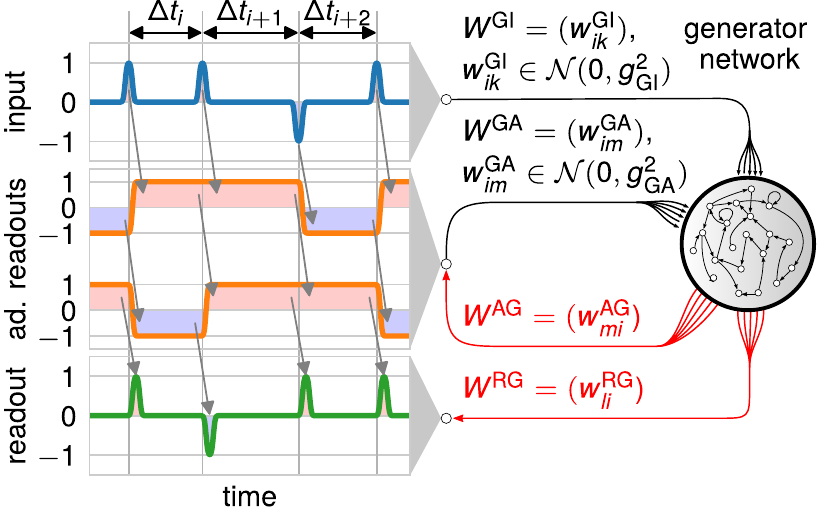
Figure 3. Setup of the benchmark N -back task to test the influence of additional, specially-trained readout neurons to cope with variances in the input timings. The input signal as well as the target signal for the readout neuron are the same as before (Fig. 1). Additional neurons, which are treated similar to readout units, are introduced in order to allow for storing task-relevant information. These additional neurons (ad. readouts) have to store the sign of the last and second last received input pulse as indicated by the arrows. The activities from GA drawn from a normal distribution with the additional neurons are fed back into the network with weights w im zero mean and variance g GA2 basically extending the network. Synaptic weights adapted by the training algorithm are shown in red. The feedback from the readout neurons to the generator network is set to be zero ( g GR = 0).